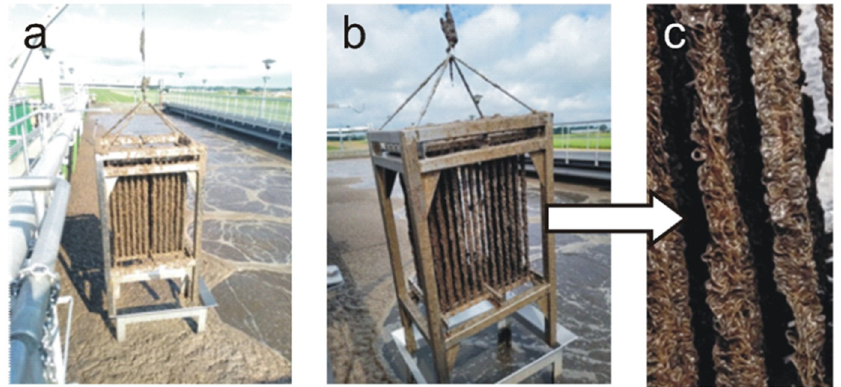
Figure 4. Single textile bed module for collecting sediment samples: fibers with a thick layer of sediment on the 59th day of operation ( a ); fibers with a thin sediment layer and visible clearances on the 114th day of operation ( b ); close-up of fibers on the 114th day of operation ( c ).